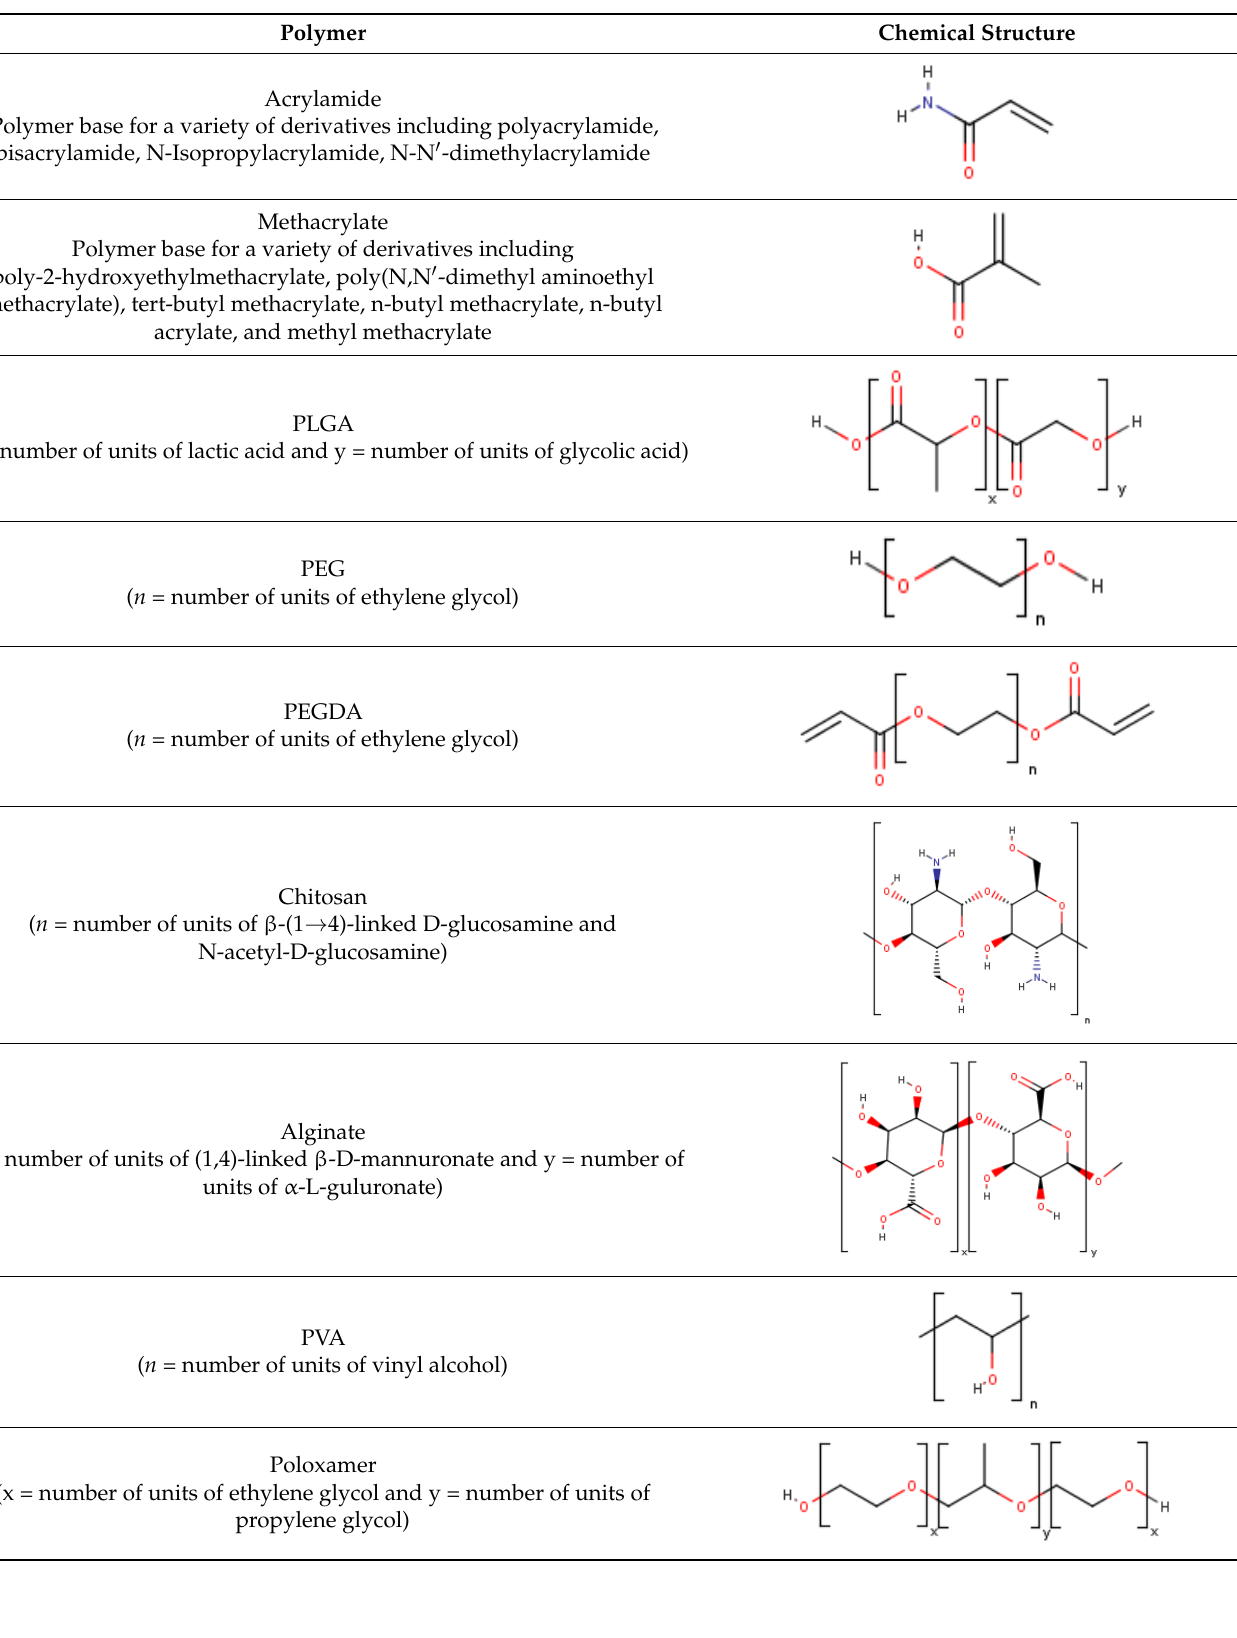
Table 1. Chemical structure of some of the most commonly used polymers in hydrogels production. PEG—polyethylene glycol, PEGDA—poly (ethylene glycol) diacrylate, PLGA—poly lactic-co-glycolic acid, PVA—poly(vinyl alcohol). The oxygen (O) atoms are highlighted in red and the nitrogen (N) atoms in blue.